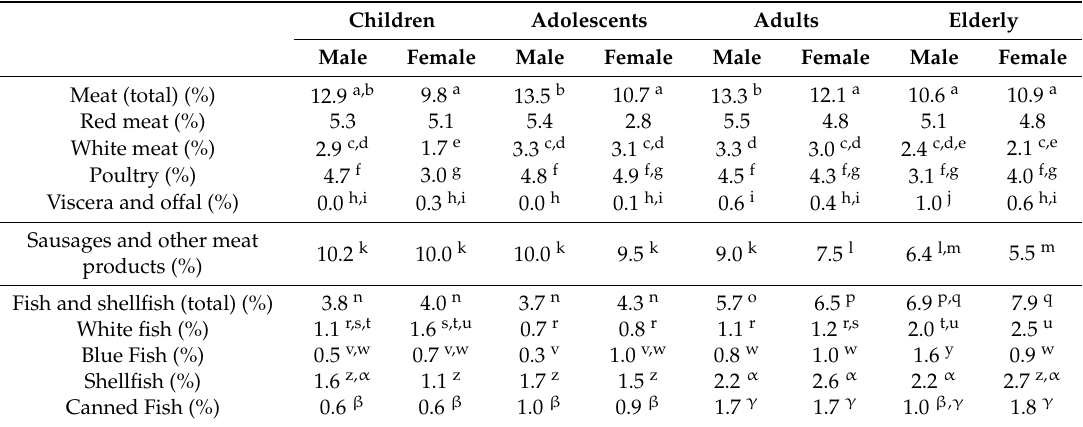
Table 8. Contribution of main meat and fish types to iron intake by gender and age